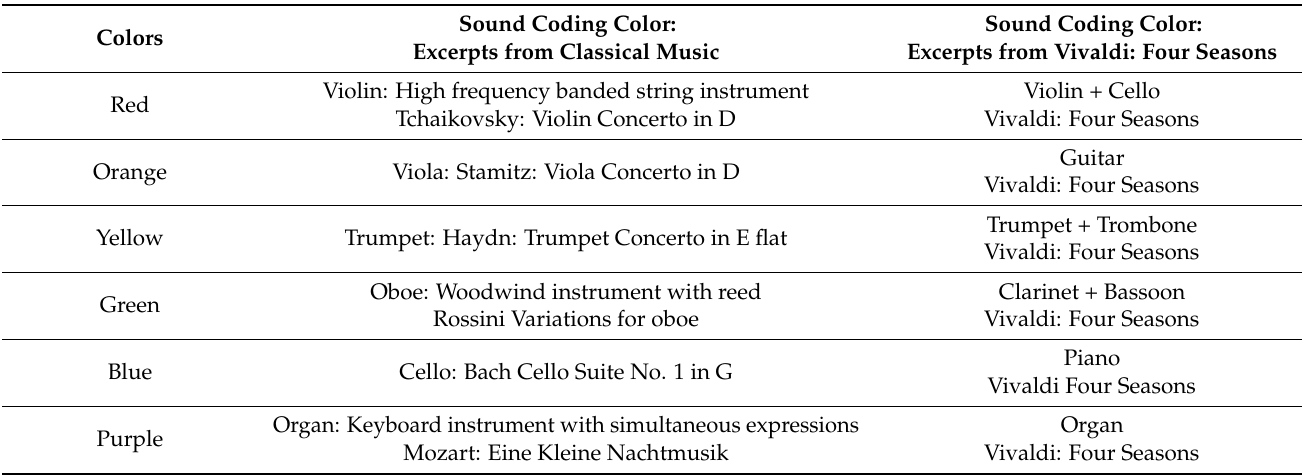
Table 4. Two sound coding colors with using instruments and classical melodies